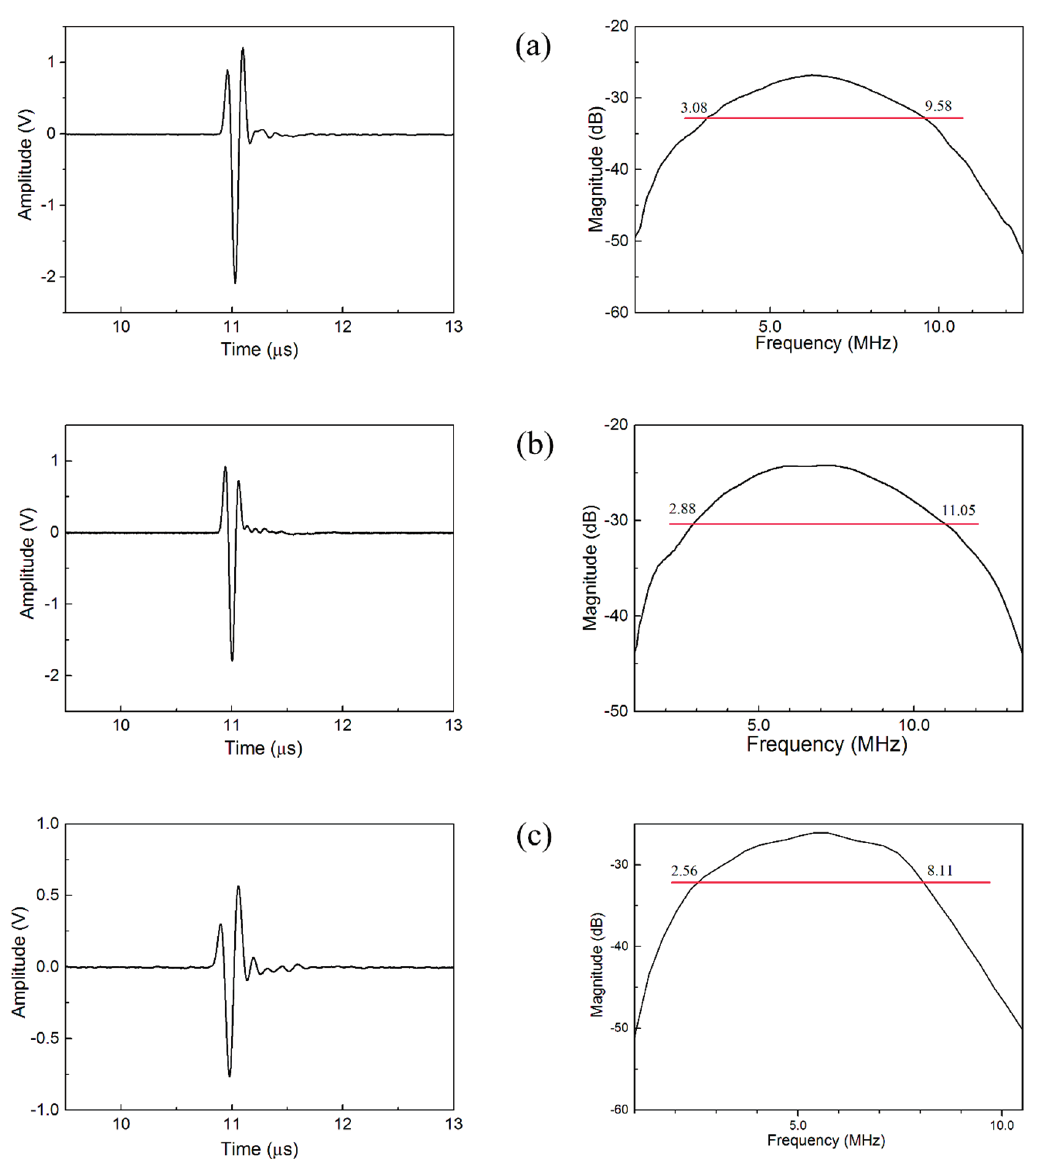
Figure 5. Comparison of the waveforms and frequency spectra of ( a ) PMNT/epoxy 1–3 composite TOFD ultrasonic transducers with scheme I; ( b ) PMNT/epoxy 1–3 composite TOFD ultrasonic transducers with scheme II, and ( c ) PZT/epoxy 1–3 composite TOFD ultrasonic